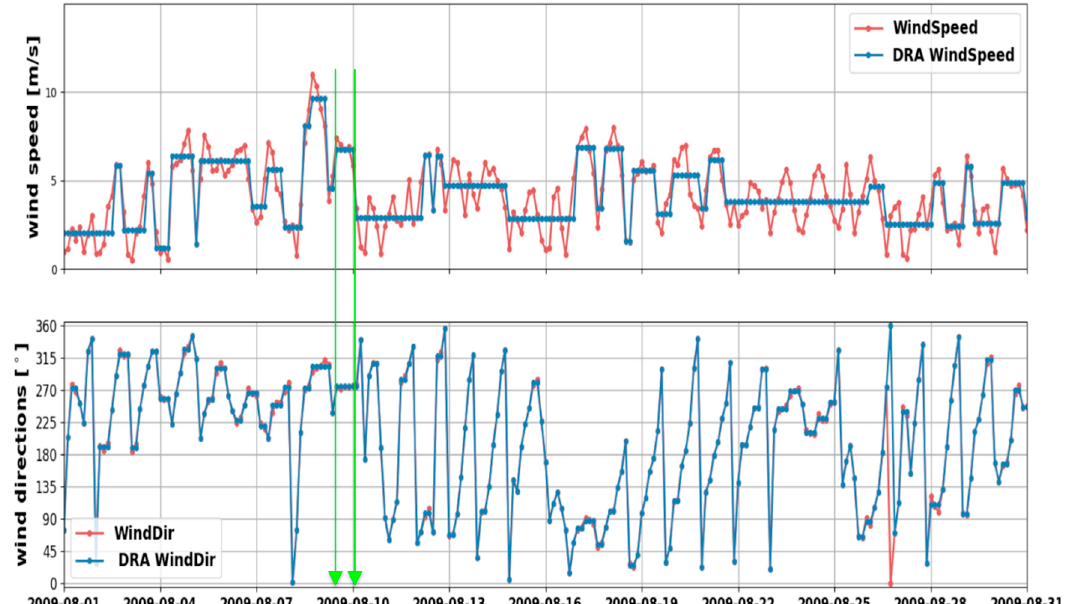
Figure 5. Top panel: time series of the wind speed (red) and the dynamical running averaged wind speed (blue). Bottom panel: time series of the wind direction (red) and the dynamically averaged wind direction (blue). Table 1. ADM ins , NOAA N, NOAA S, ECMWF, NOAA Offshore coordinates, and water depths.